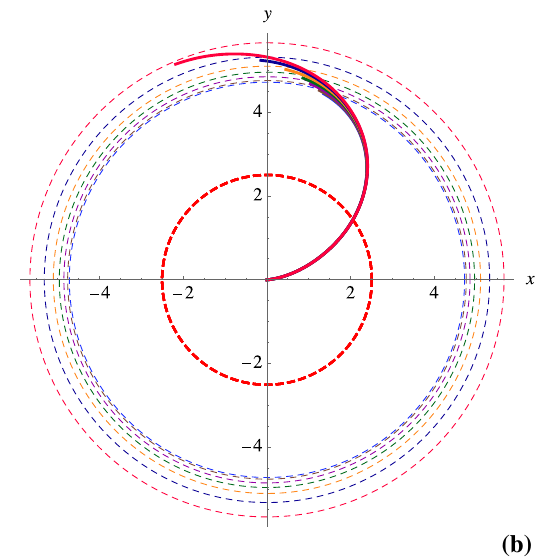
Fig. 12 The deflecting time-like trajectories, a OFK and b OSK plot- ted for the same values of energy as those used in Fig. 11. The thin dashed circles indicate r D for the OFK, and r F for the OSK. The value